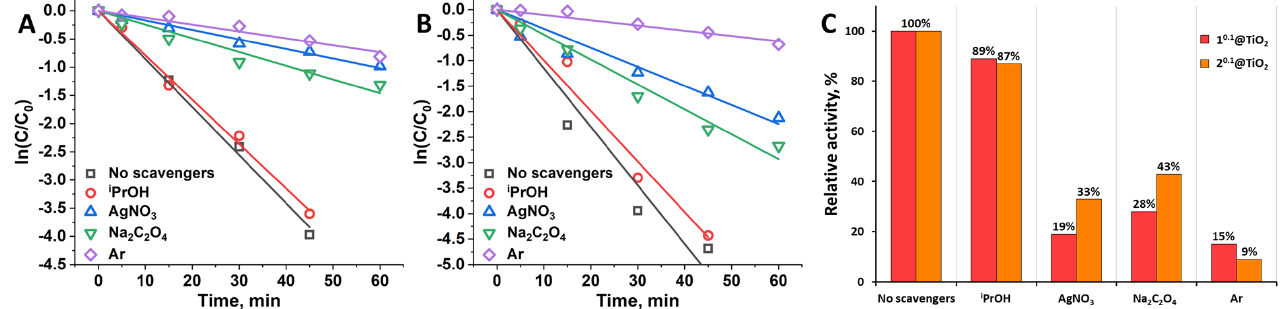
Figure 8. Effect of scavenger type on the rate constants of photocatalytic degradation of RhB in the presence of 1 0.1 @TiO 2 ( A ) and 2 0.1 @TiO 2 ( B ); Relative activity of the catalysts in the presence of different scavengers ( C ).